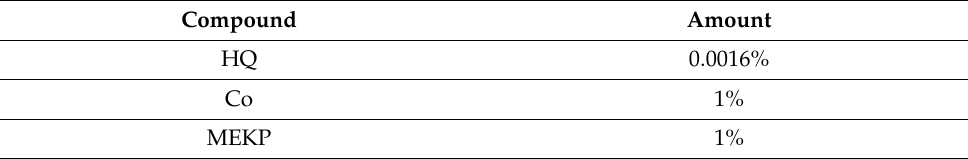
Table 4. Catalytic system for UP curing.